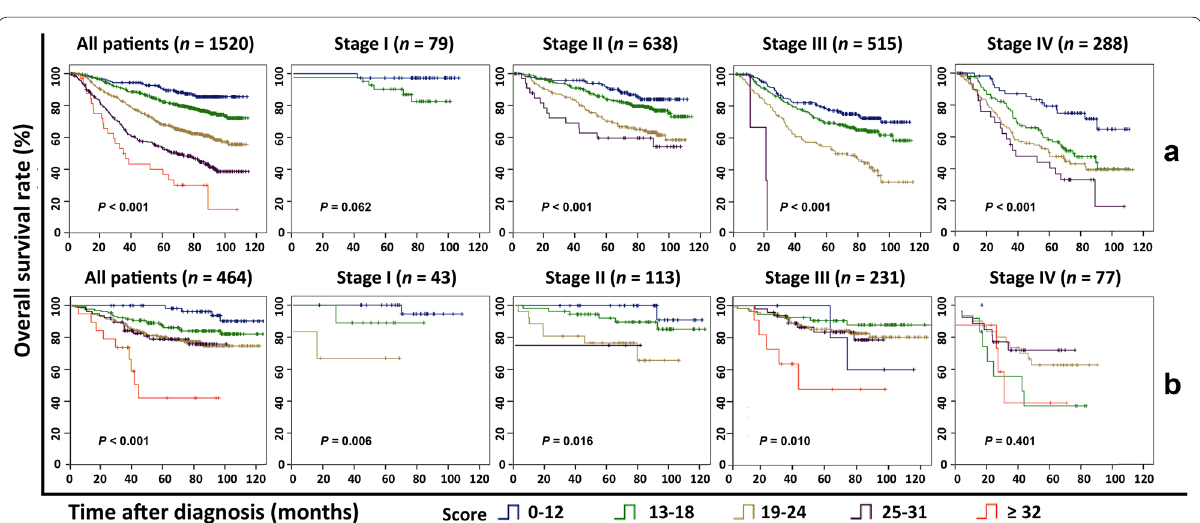
Fig. 3 Kaplan–Meier OS curves of non-metastatic NPC patients in each stage stratified by the scores of risk (0–12, 13–18, 19–24, 25–31, and the internal validation cohort ( a ) and IMRT cohort ( b ) (pooled log-rank